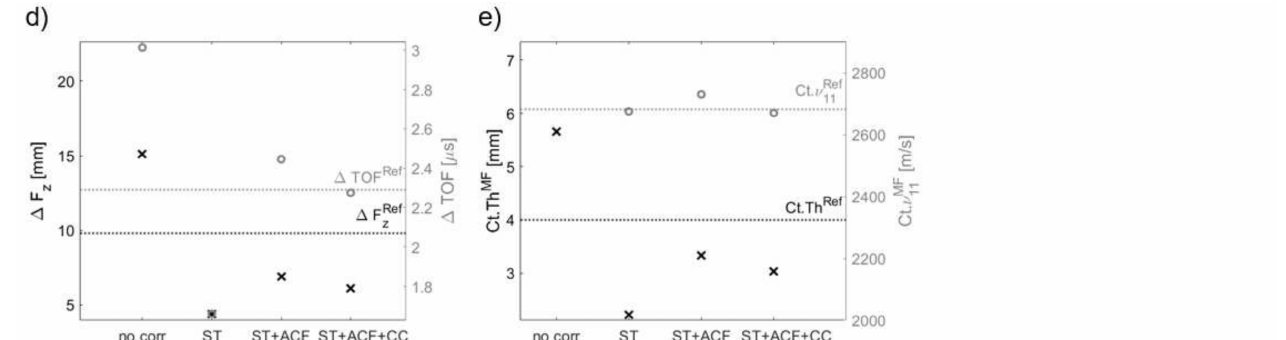
Figure A5. Model r40dx0Po20 : ( a ) Comparison of tracked amplitude at each correction step for frontside amplitudes (tracked amplitude after ST, ST + ACF and ST + ACF + CC correction overlap). The reference-tracked amplitude of the plate model was shown by the grey dashed line ( b ) and backside amplitudes (tracked amplitude after ST and ST + ACF correction overlap), respectively. ( c ) Curvature parameter p 1 , retrieved from second order fit of using CC, as a function of focal depth (black circles). Linear fit (red line) was used to retrieve F z,B at zero-crossing point. ( d ) Comparison of focus shift ∆ F z and shift (black crosses) in time-of-flight ∆ TOF (grey circles) to the reference ∆ F z Ref (dashed black line) and ∆ TOF Ref (dashed grey line) of the plate model. ( e ) Estimated Ct . Th MF and Ct. ν 11 MF after each correction step compared to the reference Ct . Th Ref (dashed black line) and Ct . ν 11 Ref (dashed grey line)